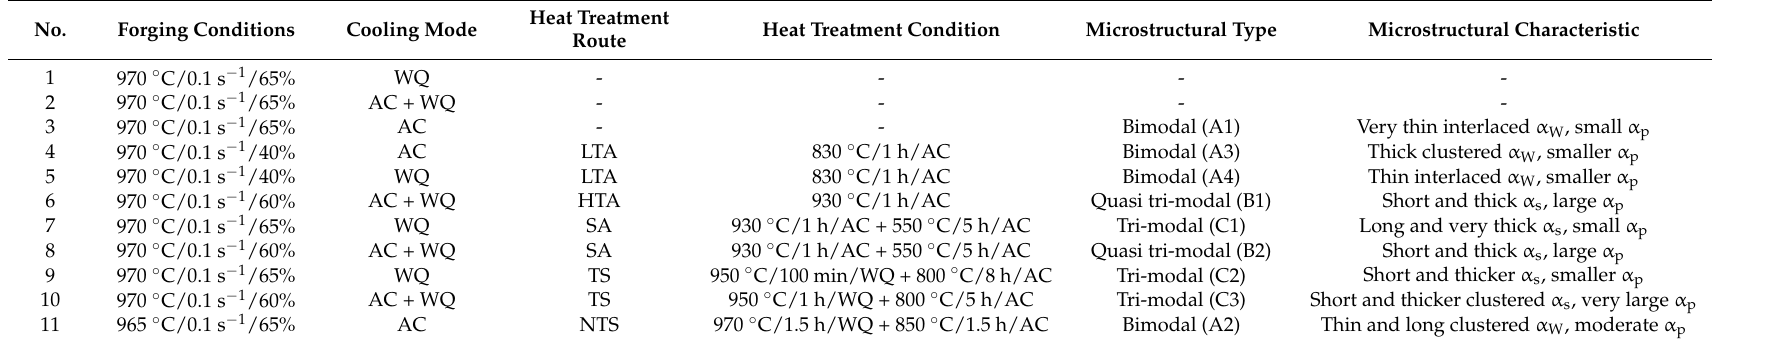
Table 2. Experimental scheme and microstructural